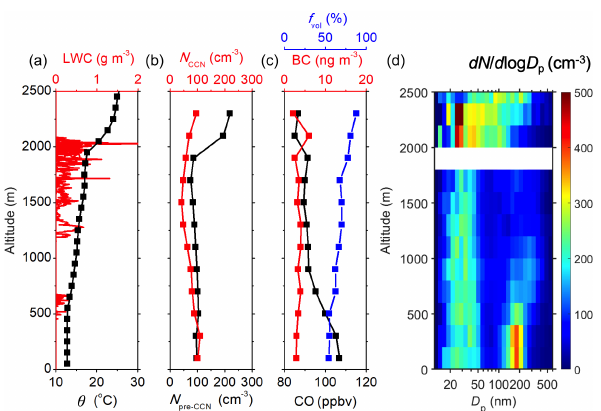
Figure 10. Vertical profiles of parameters under the synoptic con- dition of pre-front on 8 February 2018. (a) Potential temperature ( θ ) and liquid water content (LWC). (b) N pre-CCN and N CCN . (c) Concentrations of carbon monoxide (CO) and black carbon (BC), as well as the aerosol volatile fraction ( f v ). (d) Vertical contour of aerosol size distributions as a function of altitude. Size distributions between 1800 and 2000m are not shown due to the interference of cloud droplet shattering. The CO mixing ratio, BC concentra- tion, particle concentrations, and size distributions are normalized to standard temperature and pressure (273.15K and 101.325kPa;